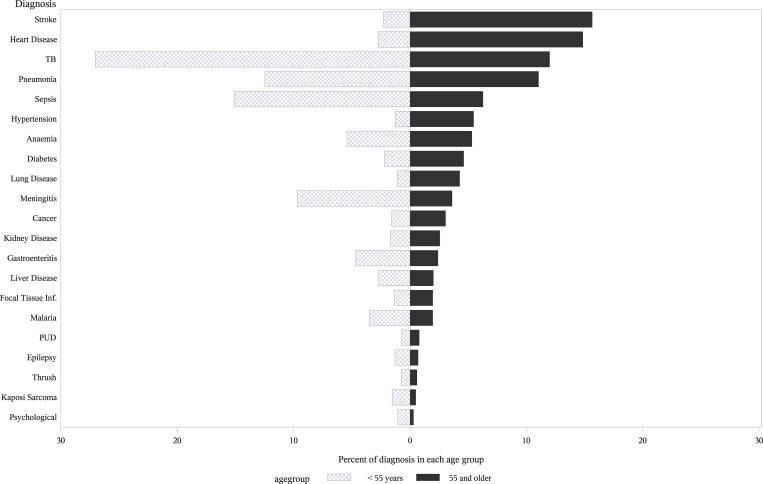
Distribution of diagnoses of adult patients by age category, Blantyre, Malawi, 2013–2014.The light grey hatched bars represent adults aged < 55 years; the solid dark grey bars represent adults aged 55 years and older.